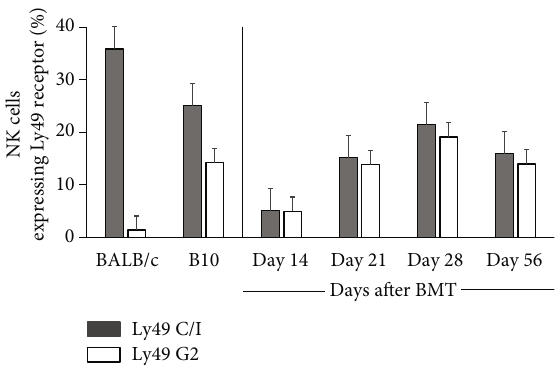
Figure 1: Distribution of Ly49 receptors on NK cells in recipient BALB/c mice before and after bone marrow transplantation. The distribution of Ly49 C/I + and L49 G2 + NK cells in BALB/c mice ( n = 12 ) and B10 mice ( n = 12 ) before transplantation was measured. Subsequently, the distribution of transplanted mice 14 ( n = 12 ), 21 ( n = 11 ), 28 ( n = 11 ), and 56 days ( n = 9 ) after BMT was measured. BMT: bone marrow transplant; NK: natural